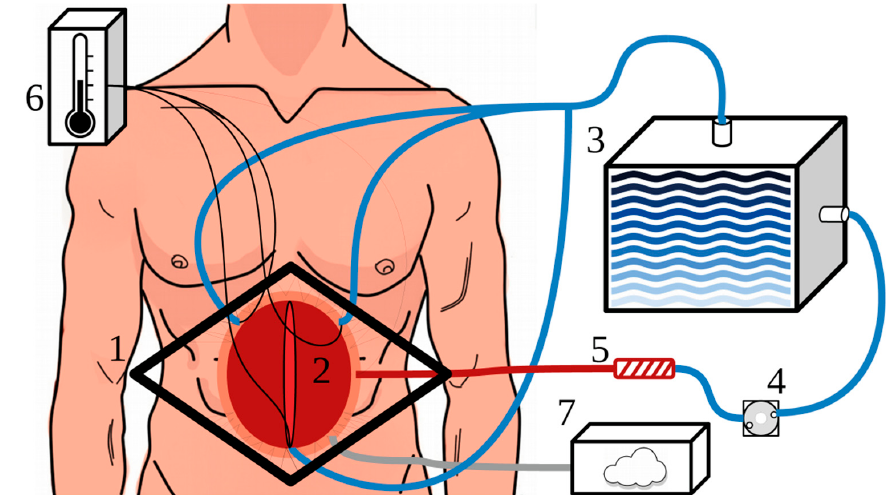
Figure 4. Schematic diagram of an open HIPEC procedure, with one inflow catheter and three outflow drains. The abdominal wall is retracted by sutures attached to a Thompson retractor (1). A plastic sheet is placed over the open abdomen (2) and an incision is made in the plastic to enable access to the abdominal contents. The heated carrier solution is stored in the reservoir (3) and is circulated by a roller pump (4). The inflow perfusate passes to a heat exchanger (5) to heat the solution to the required temperature. The temperatures are monitored during the treatment (6), usually in the left-subphrenic area, right-subphrenic area, pelvic area near the outflow drains, and in or near the inflow catheter. The smoke evacuator (7) is placed under the plastic sheet to prevent the aerosolization of chemotherapy.